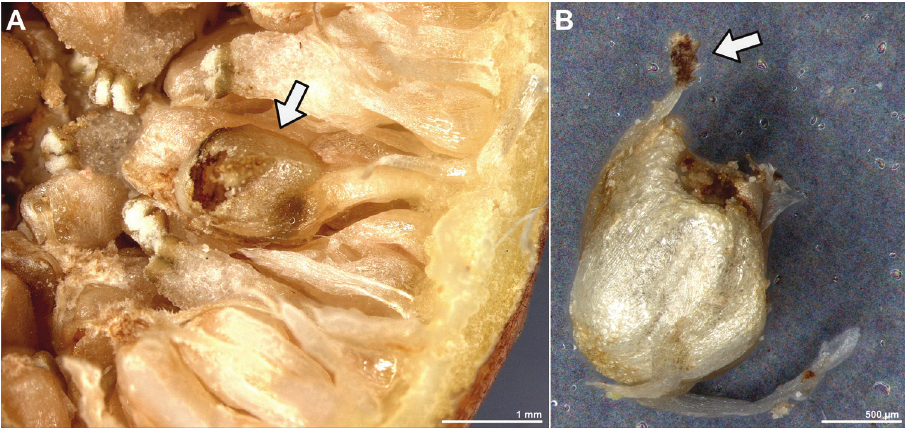
Figure 2. A Detail of galls induced by Sycobia hodites Farache & Rasplus, sp. n. arrow indicates the gall. B Arrow indicates remains of flower stigma in the gall.